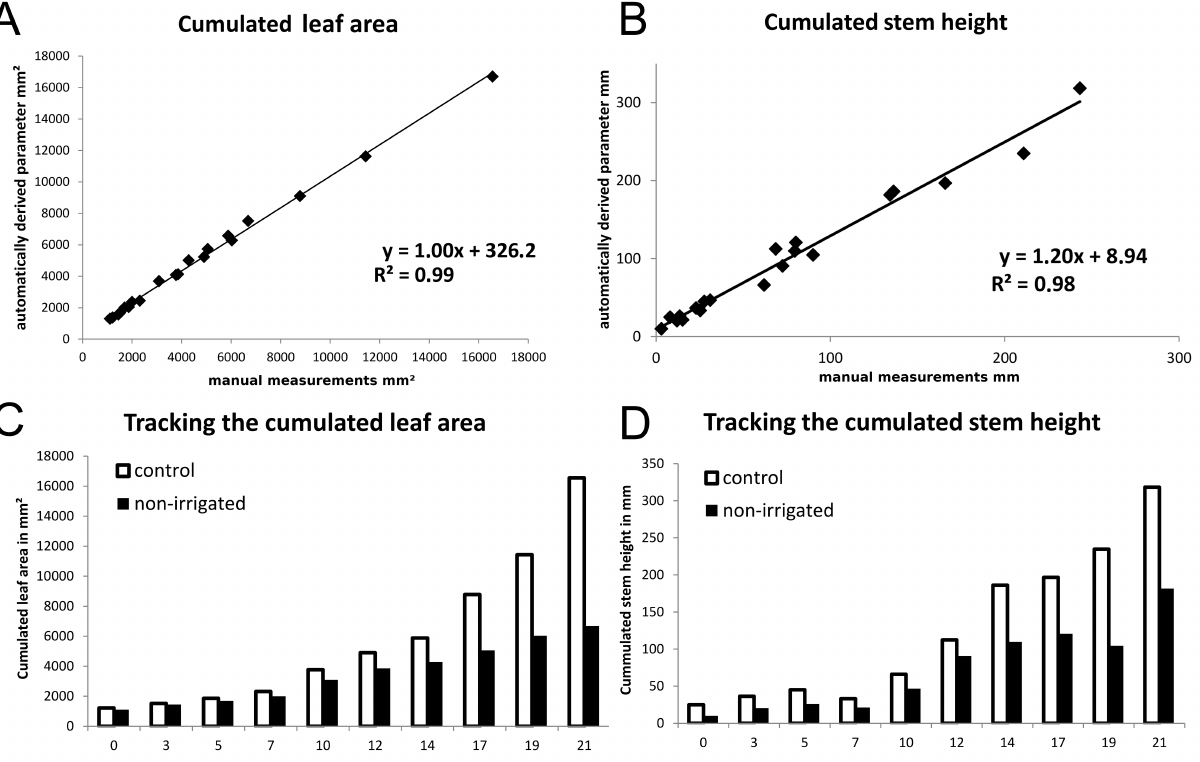
Figure 6. The correlation of the leaf area compared to manually-taken parameters is shown in ( A ); ( B ) the comparison for the parameter cumulated stem height. Repeated measurements of the irrigated and the non-irrigated plant can be used for the tracking of defined parameters in the time course ( C , D